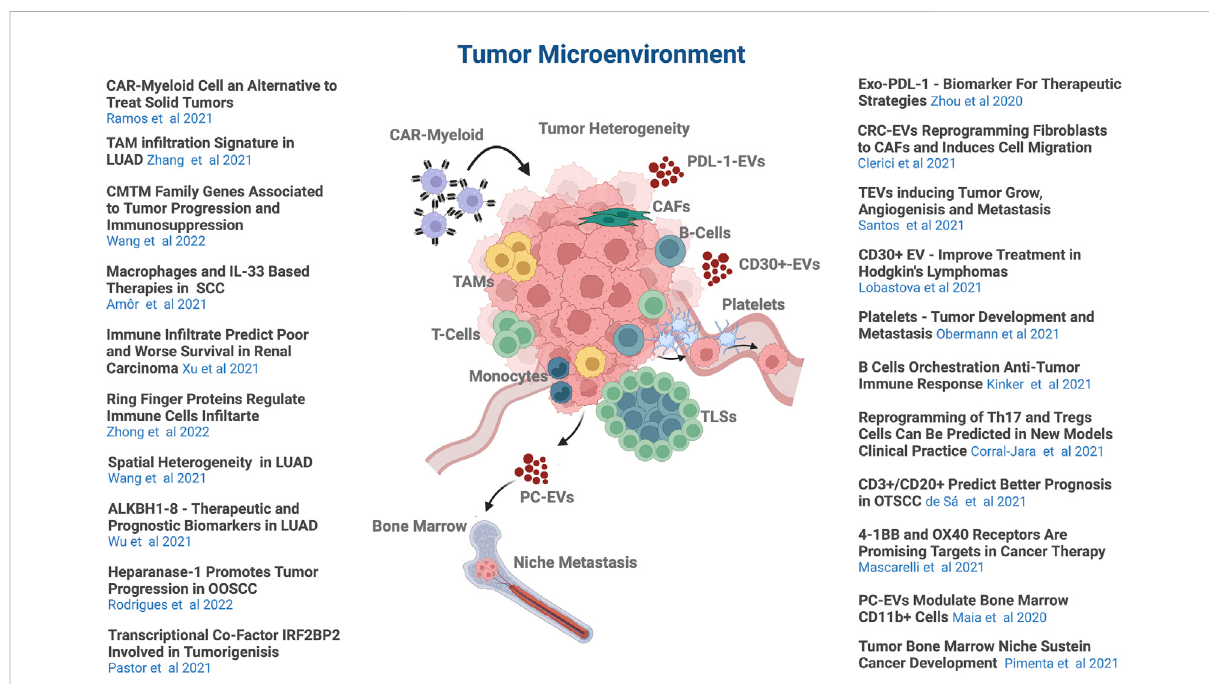
FIGURE 1 The tumor microenvironment. A schematic view of the tumor microenvironment components and all scienti fi c contributions in this Topic Research. The picture was created with